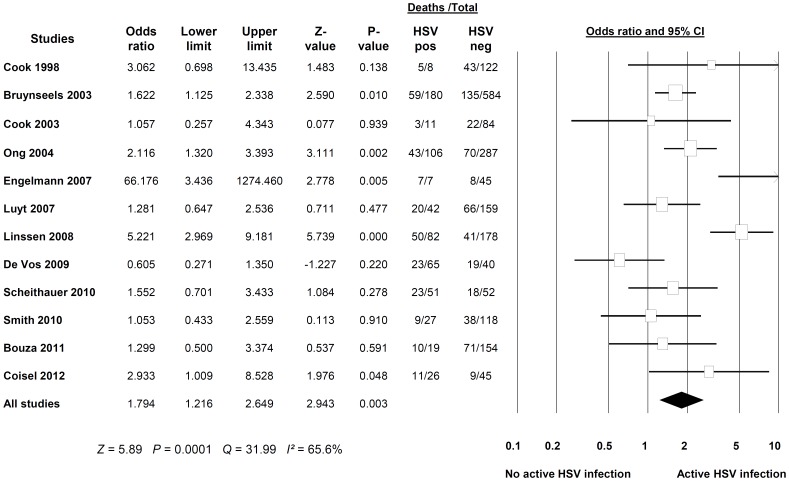
Meta-analyse of the mortality associated with Herpes Simplex Virus (HSV) Diagnosis methods are detailed in
table 6
.